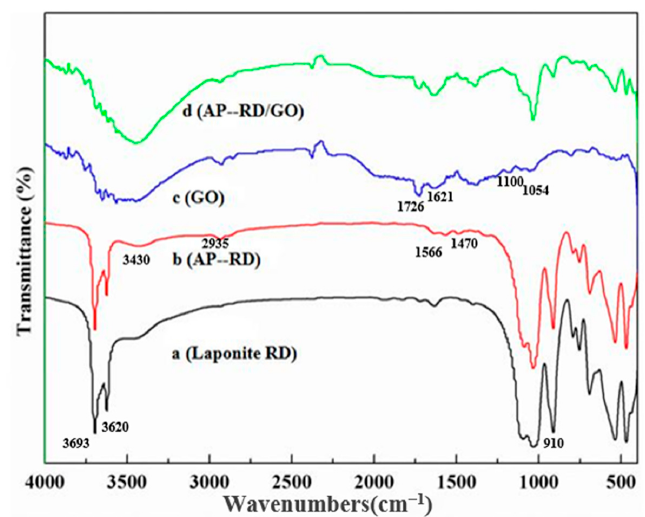
Figure 4. Infrared spectra of RD, AP–RD, GO, AP–RD/GO.